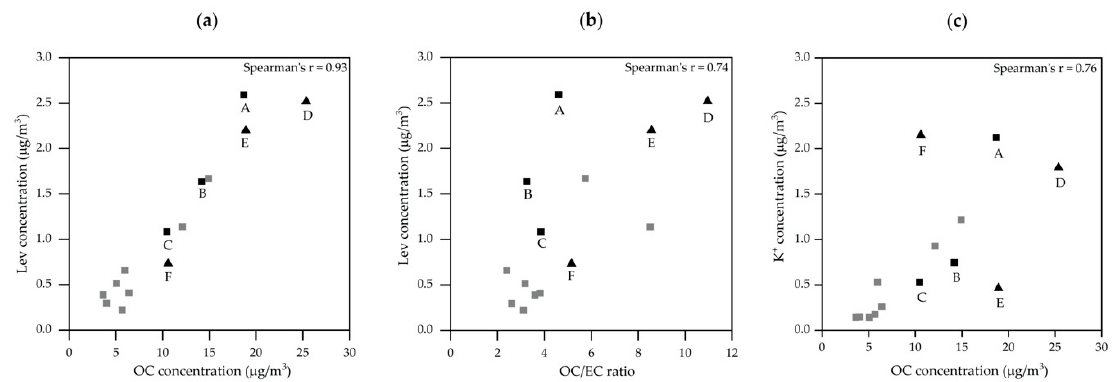
Figure 7. ( a – c ). Correlation between levoglucosan (Lev), OC, and K + concentrations in PM 2.5 samples